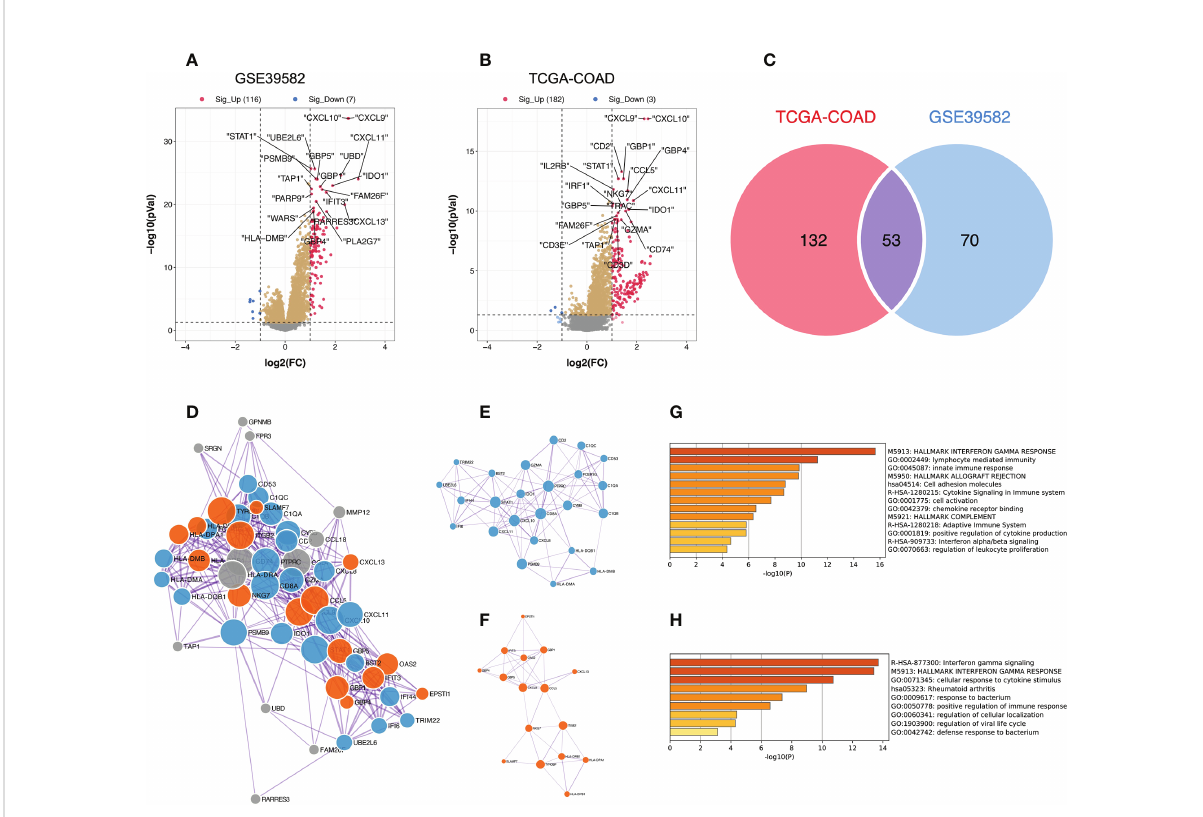
FIGURE 2 Identi fi cation of key gene modules from DEGs between the high and low TME immune score groups; DEGs, differentially expressed genes. (A, B) DEGs between the high and low TME immune score groups in the GSE39582 and TCGA-COAD datasets. The red dots represent signi fi cantly upregulated genes, and the blue dots represent signi fi cantly downregulated genes (adjusted P value < 0.05 and |log2FC| > 1); FC, fold change. (C) The Venn diagram reveals the intersection of DEGs in the GSE39582 and TCGA-COAD cohorts. (D) Protein-protein interaction network generated from the STRING database. The size of the nodes indicates the degree, which denotes the number of how many interactions (at the score threshold) that a protein has on the average in the network. The thickness of the edge indicates the combined score, which represents the con fi dence of the link between two proteins. (E, F) Critical sub-network components in the PPI network identi fi ed by the MCODE algorithm. MCODE, Molecular Complex Detection; PPI, protein-protein interaction. (E) MCODE cluster 1; (F) MCODE cluster 2. (G, H) Bar graph of enriched pathways across gene lists in MCODE cluster 1 and 2, colored by P